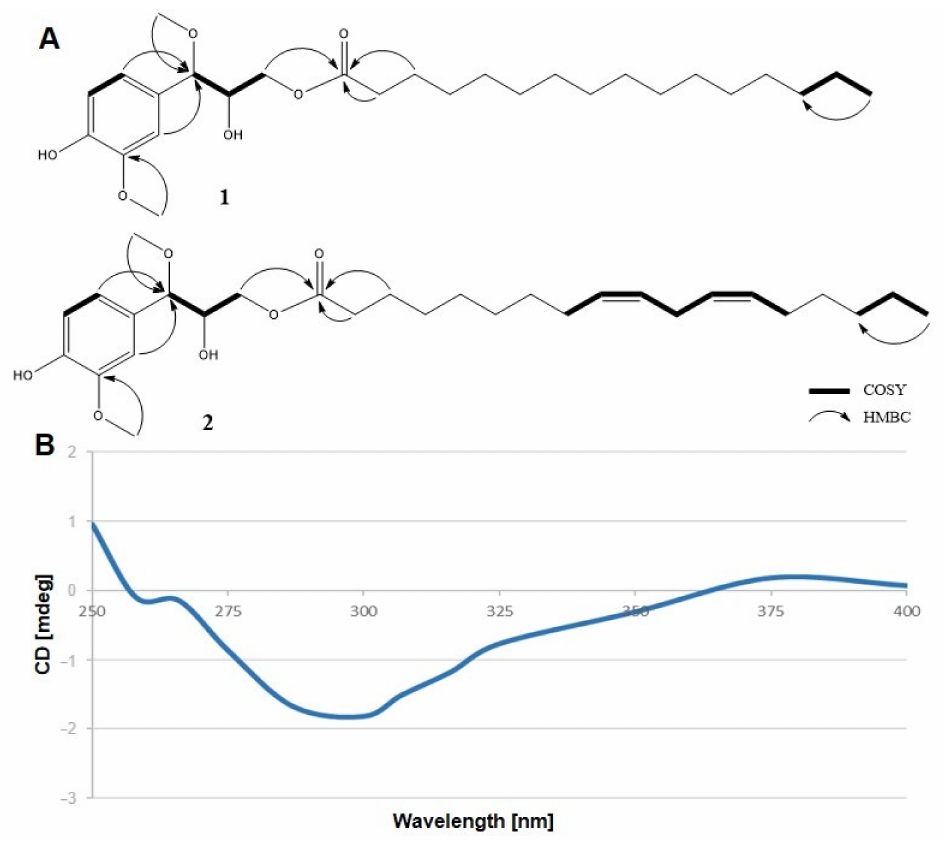
Figure 2. Key COSY and HMBC correlations of 1 and 2 ( A ) and the ICD spectrum of 1a ( B